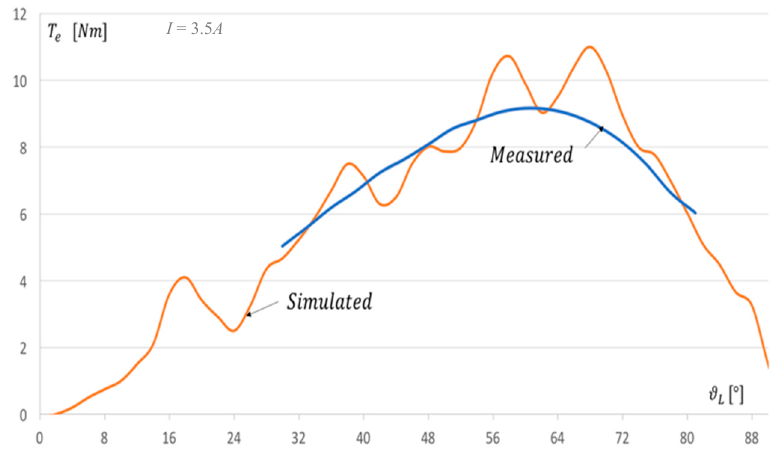
Figure 8. Torque comparison from measurement and FEM analysis at rated current.